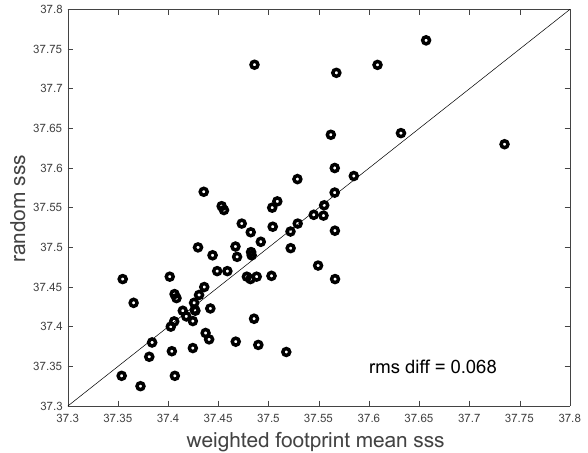
Figure 6. Weekly weighted mean SSS for SPURS-1 ( x -axis) vs. a random value picked out from the ensemble from which the weighted mean was computed ( y -axis). Each circle is from a di ff erent 7-day block during the SPURS-1 period. The line is where the two values are equal.